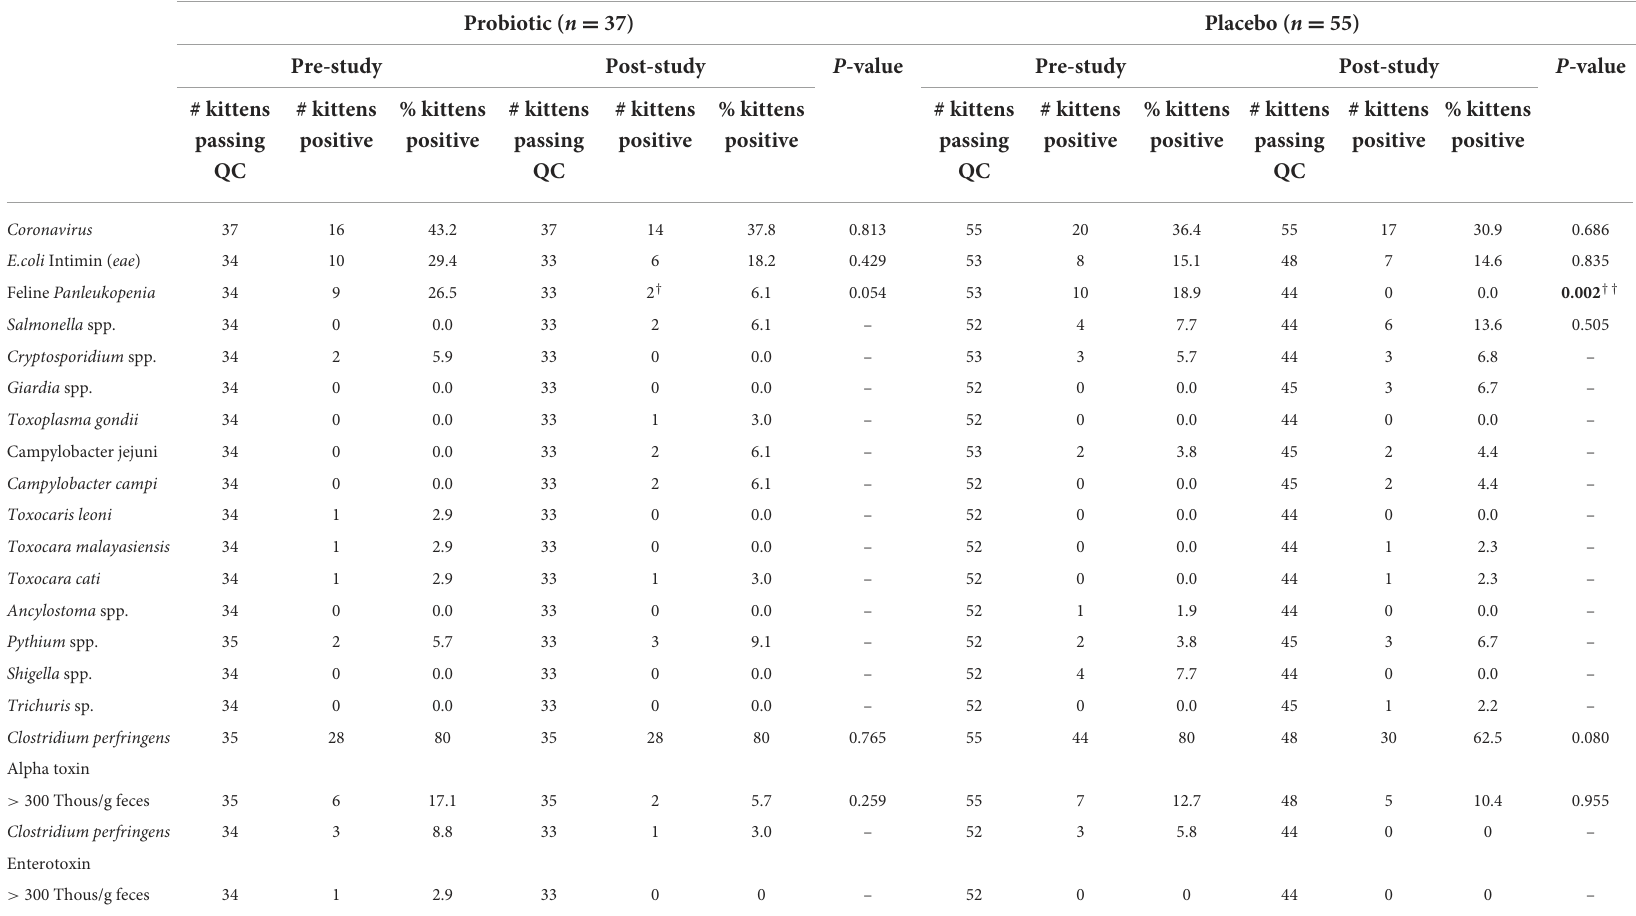
TABLE 2 Prevalence of infectious agents identified by RT-PCR or PCR in RNA/DNA extracted from voided feces collected from fostered kittens prior to (pre-study) and upon completion (post-study) of ongoing daily treatment with a probiotic or placebo. Selected agents Prevalence/presence of infectious agent(s) Probiotic ( n = 37) Placebo ( n = 55) Pre-study Post-study P -value Pre-study Post-study P -value